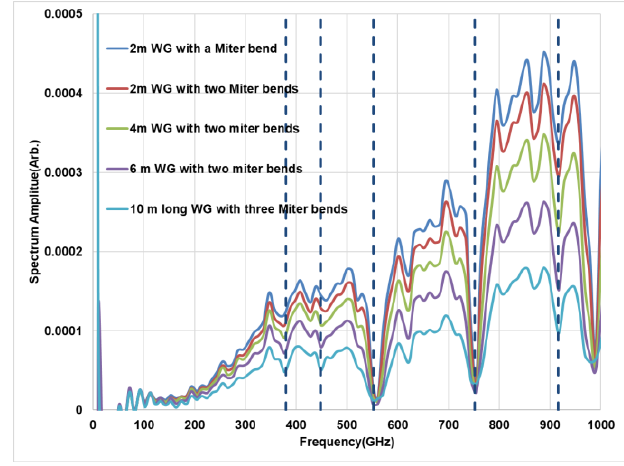
Fig. 3: Measured spectra for various TL sections Corresponding to different TL lengths, the transmission attenuation is derived as shown in Figure 4.